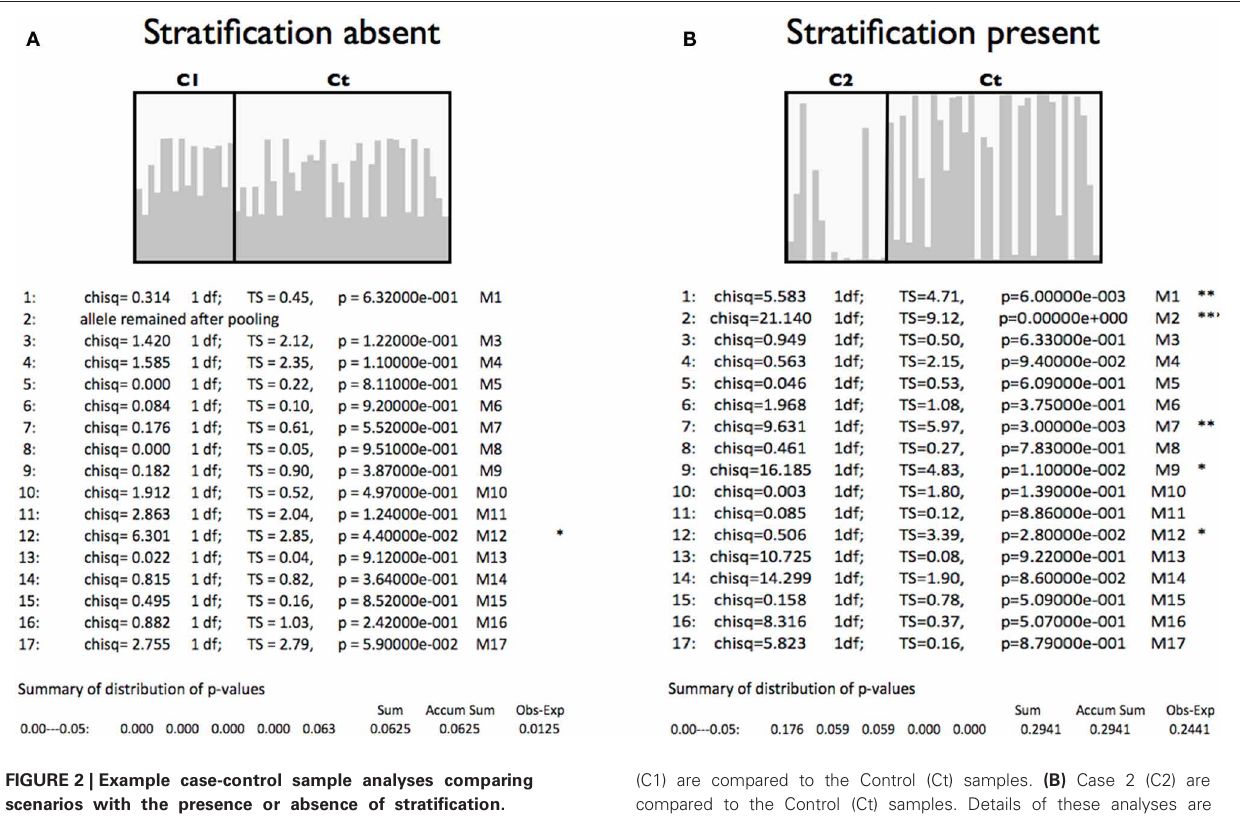
FIGURE 2 | Example case-control sample analyses comparing scenarios with the presence or absence of stratification. STRUCTURE bar plots and STRAT table results are shown. (A) Case 1